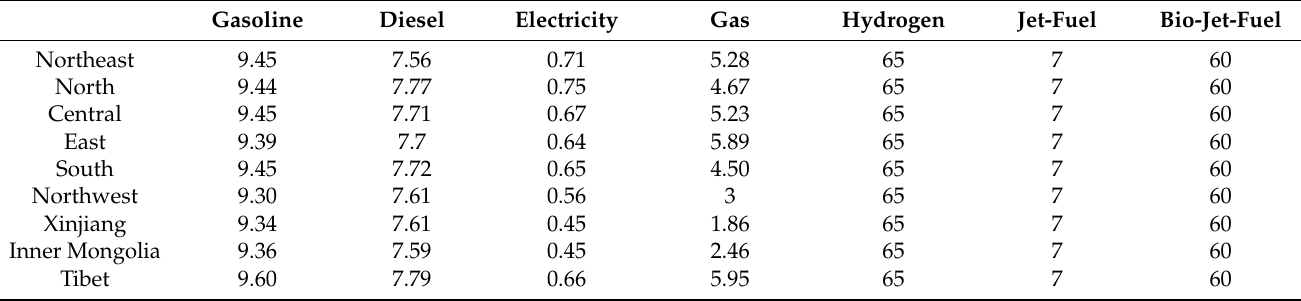
Table A4. Costs of fuels in 2020